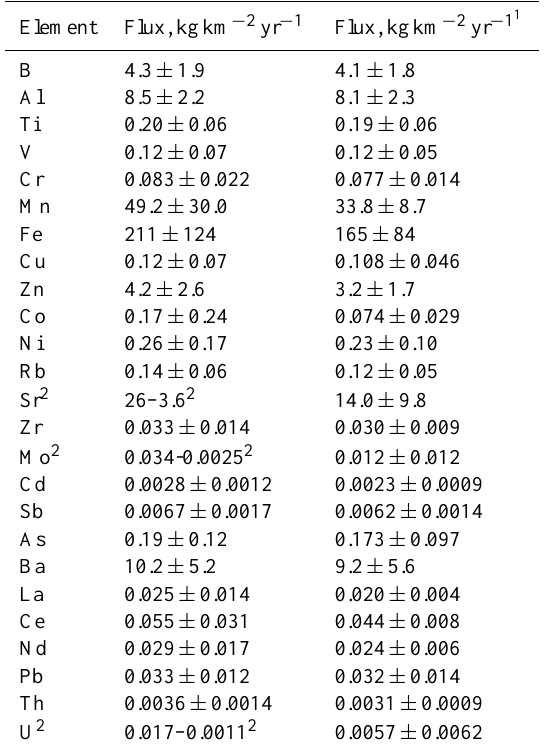
Table 2. Latitude-averaged (56–67 ◦ N) export fluxes ( ± 2 SD) of TEs by rivers of the